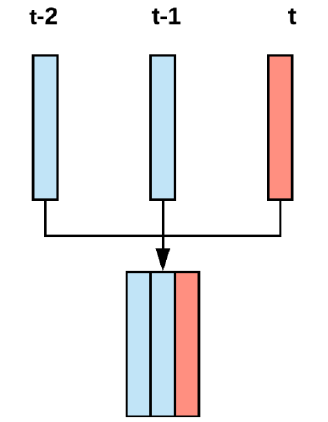
Figure 1 The method to stack images (The red rectangle is key frame and the blue rectangles are attached frame) For reference convolutional neural network, images are used separately to train the network and do validation and testing part. This means that the model is trained with single